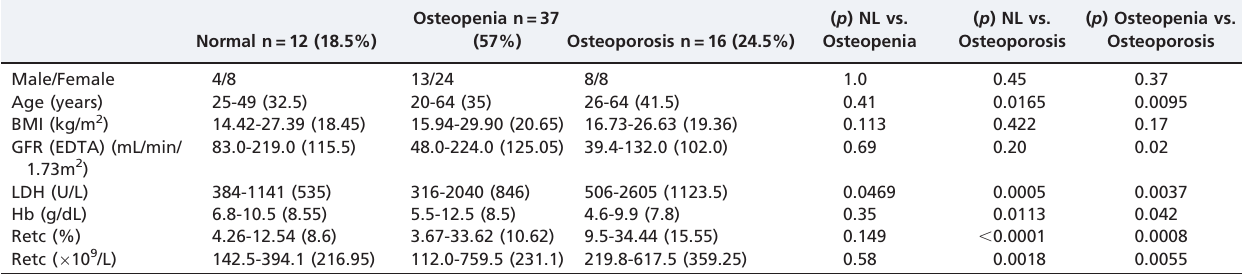
Table 1 - Clinical characteristics of patients with SCD who have normal BMD, osteopenia or osteoporosis. Data are presented as minimum-maximum (median). All p- values were obtained using the Mann Whitney test for numerical values and Fisher’s Exact Test for